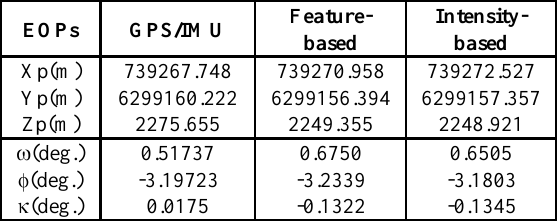
Table 1. Estimated EOPs of aerial image